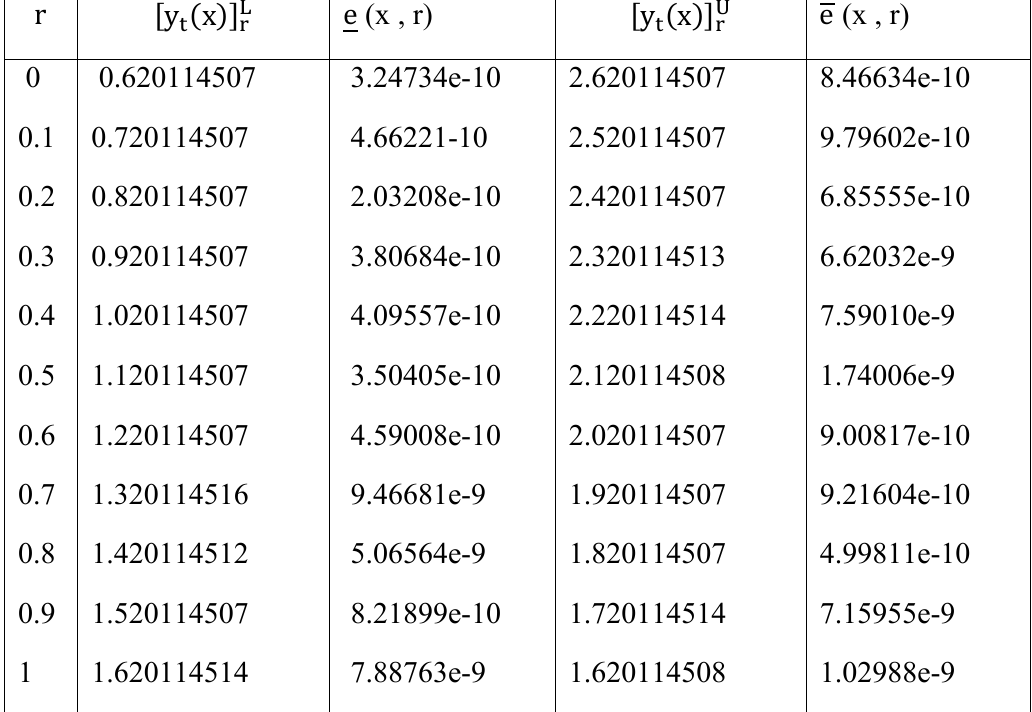
Table (2): Numerical result for example (2),